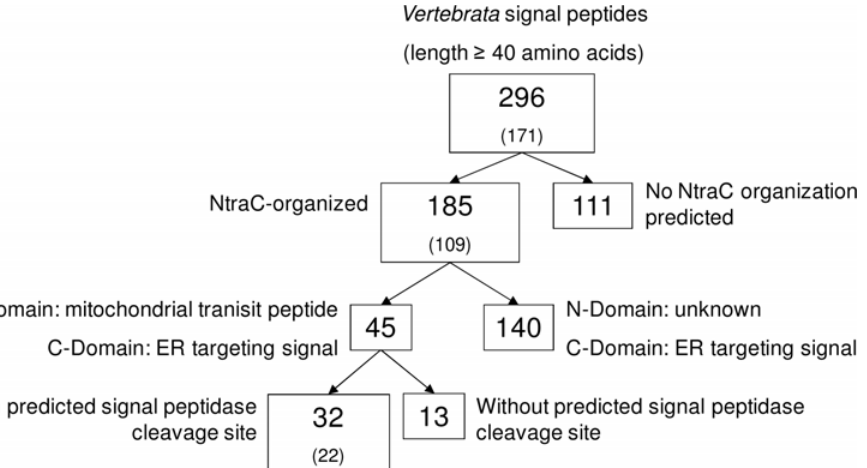
Figure 1. Overview of NtraC-organized sequences among long signal sequences found in vertebrate proteins. Set sizes without orthologues are given in brackets. The numbers represent conservative estimates based on validated prediction tools for targeting signal recognition and turn structure prediction.